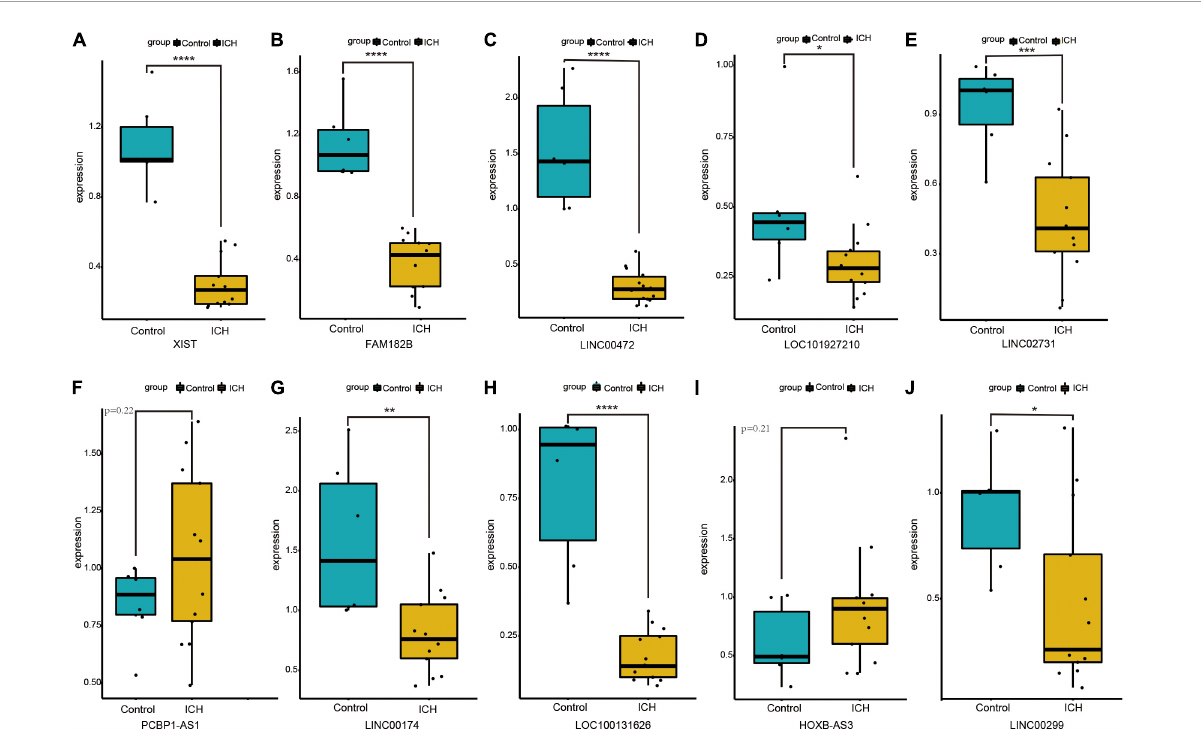
FIGURE6 The expression of ten DElncRNAs in peripheral blood of ICH patients compared with control subjects using qRT-PCR. (A) The qRT-PCR results of XIST. (B) The qRT-PCR results of FAM182B. (C) The qRT-PCR results of LINC00472. (D) The qRT-PCR results of LOC101927210. (E) The qRT-PCR results of LINC02731. (F) The qRT-PCR results of PCBP1-AS1. (G) The qRT-PCR results of LINC00174. (H) The qRT-PCR results of LOC100131626. (I) The qRT-PCR results of HOXB-AS3. (J) The qRT-PCR results of LINC00299. * P < 0.05, ** P < 0.01, *** P <